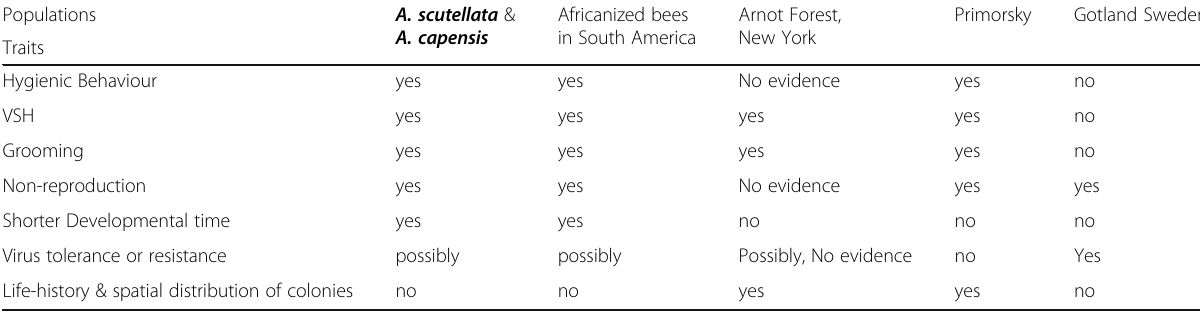
Table 1 Traits that have been measured and/or invoked to explain resistance Populations